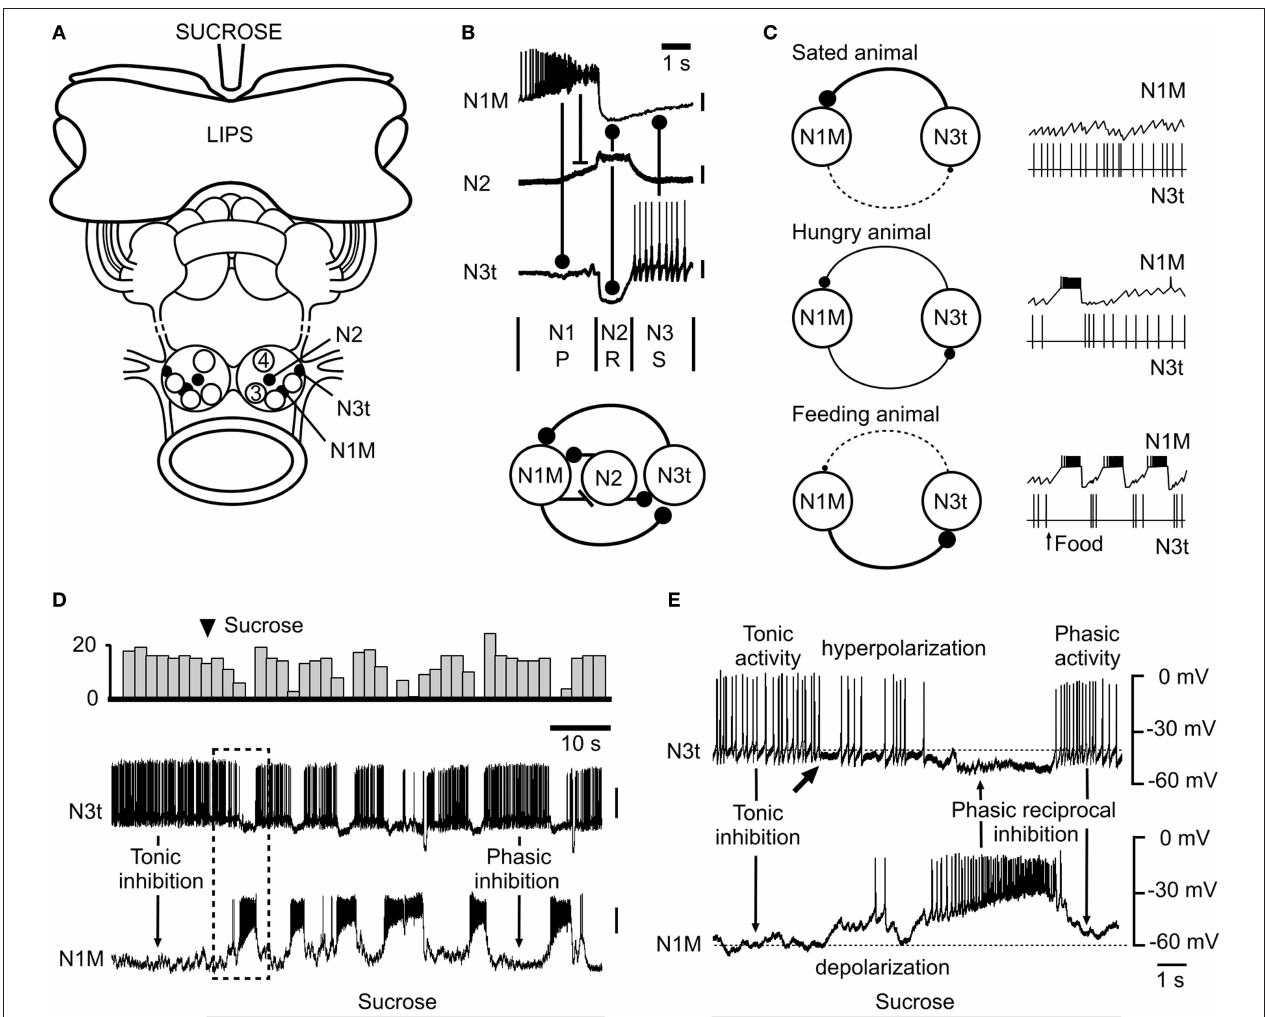
rhythm. The thickness of the continuous lines connecting the N1M and N3t cells (left) indicates the strength of the inhibitory effects between the cells and the dashed lines the absence of phasic inhibitory effects. (D) An experiment in the semi-intact preparation showing that a food stimulus reduces the suppressive inhibitory control by the N3t cell and releases rhythmic fictive feeding activity. The change in the pattern of N3t firing is emphasized by the top trace where the number of N3t spikes is accumulated in 3s bins. (e) Expansion of the boxed area shown in (D) shows the first cycle of fictive feeding activity in the N1M after the sucrose-induced reduction in N3t firing rate. The arrow under the N3t trace indicates the point at which N3t starts to hyperpolarize and its tonic spike frequency begins to decrease. This decrease in N3t firing is followed by complete suppression of N3t firing when the N1M becomes active and synaptically inhibits the N3t. The subsequent phasic N1M-N3t reciprocal inhibition leads to the alternating patterns of N1M/N3t firing seen throughout the feeding pattern that follows. In (A) to (C) a stick indicates an excitatory synaptic connection between neurons and a ball indicates an inhibitory synaptic